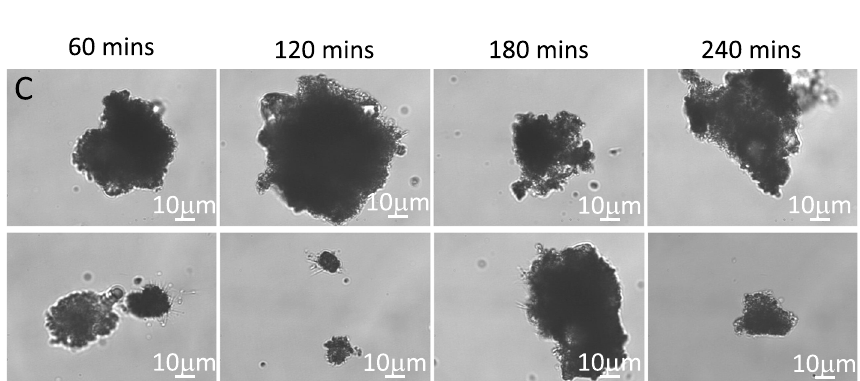
Fig. 21 1 L scale up. A Dissolution profile for a 1 L sample of 125 mg/L fresh Yomesan, 0–180 min (black filled symbols), and a 300 µM 20 mL sample (red squares) from Fig. 4A. Dashed lines are the logarithmic fits to both sets of data. B Dissolution profile for both samples 0 to days 2, 4, and 5 at final pHs of 9.33 and 9.17, respectively. C Optical microscope representative images of niclosamide aggregates for the 1 L sample at 60 to 240 min of dissolution-stirring that show very little change in